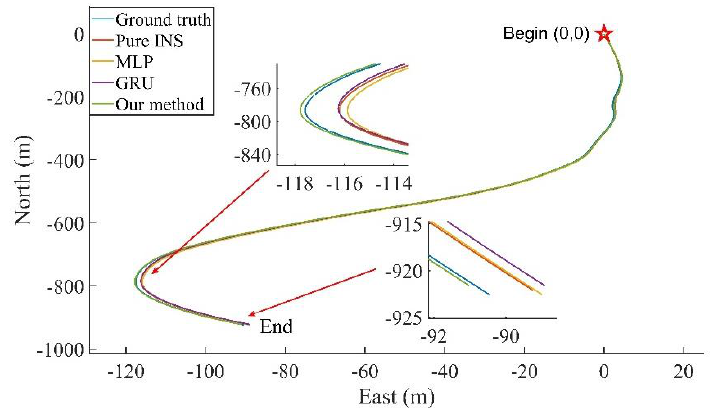
Figure 10. The horizontal position error result of 60 s outage of Experiment 1.